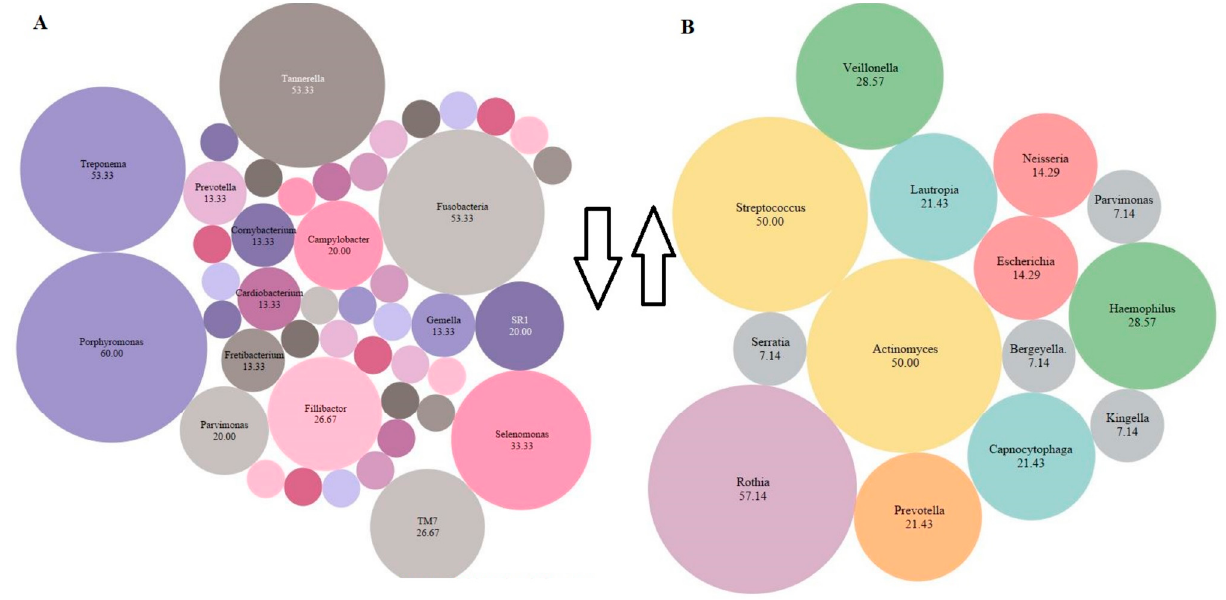
Figure 3. The most abundant species present across all the studies post-intervention. The percentage of abundance was calculated by cumulative % of all bacterial species present in the included articles. The size of the bubble is related to the abundance (higher abundance = large bubble). The smaller bubbles represent species <7% ( Megasphaera , Oribacterium , Peptococcus , Peptostreptococcus, Solobacterium , Actinomyces , Atopobium, Bacteroidacea , Clostridiales , Cornynebacterium , Dialaster , Granulicatella , Kingella , Mogibacterium , Olsnella , Propionibacterium , Spirochates , Stretococcus, Veillonella. ( A ) Decrease (downward arrow) in species post-intervention ( B ) Increase (upward arrow) in species post-intervention. The drawing was made in Tableau version 9.1, Seattle, WA, USA.